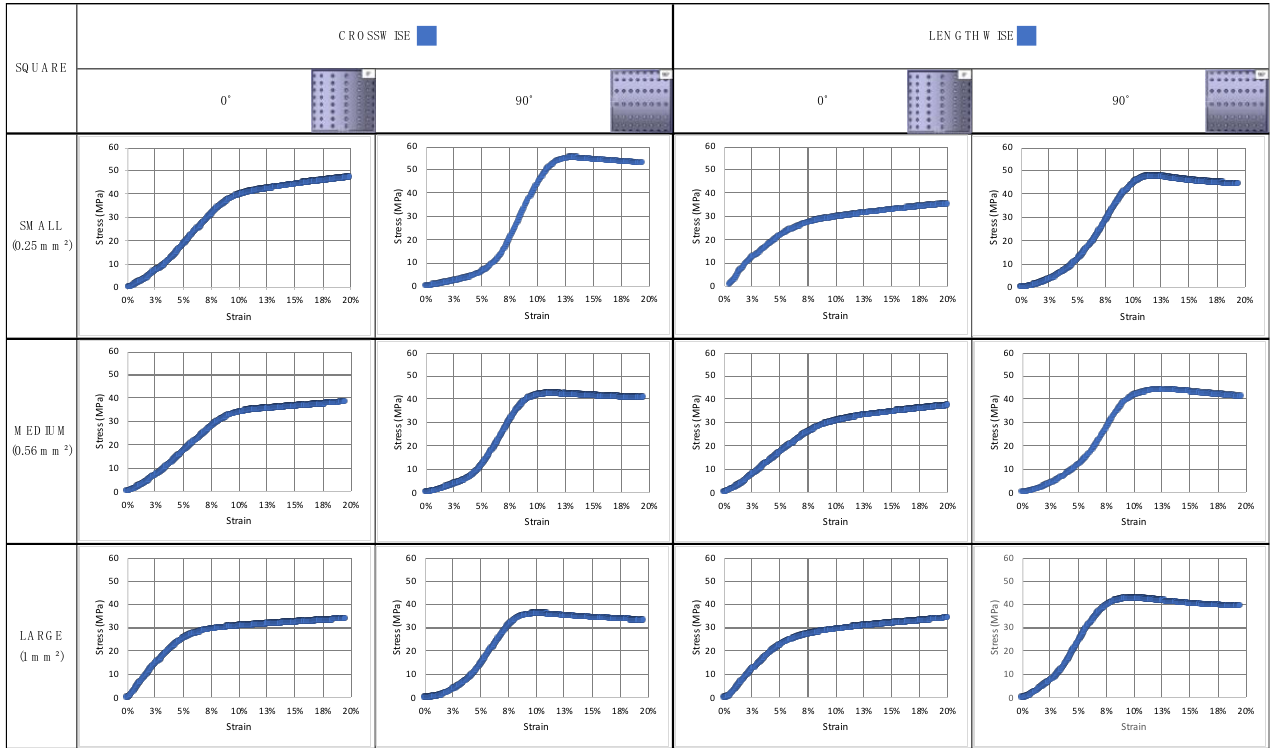
Figure 3. Representative stress-strain curves obtained by experimental testing for each model and printing orientation. Experiments were performed, n = 5.